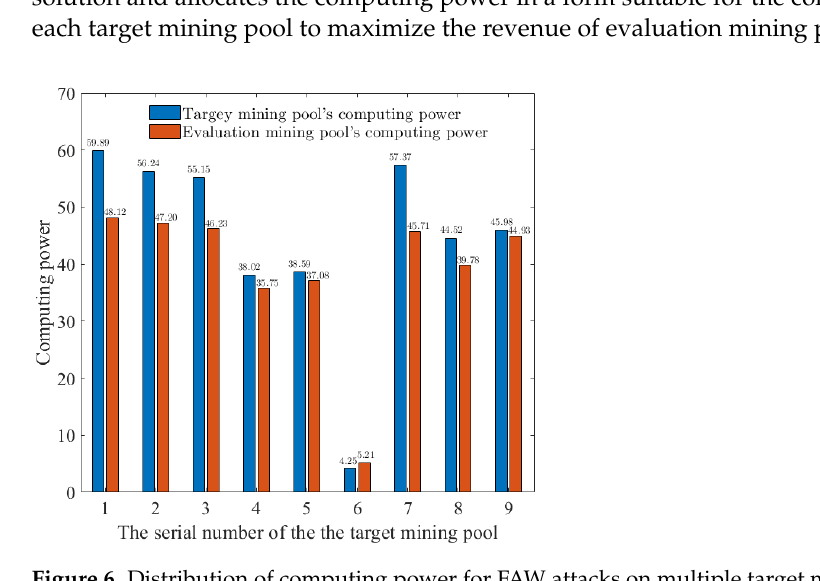
Figure 6. Distribution of computing power for FAW attacks on multiple target mining pools.